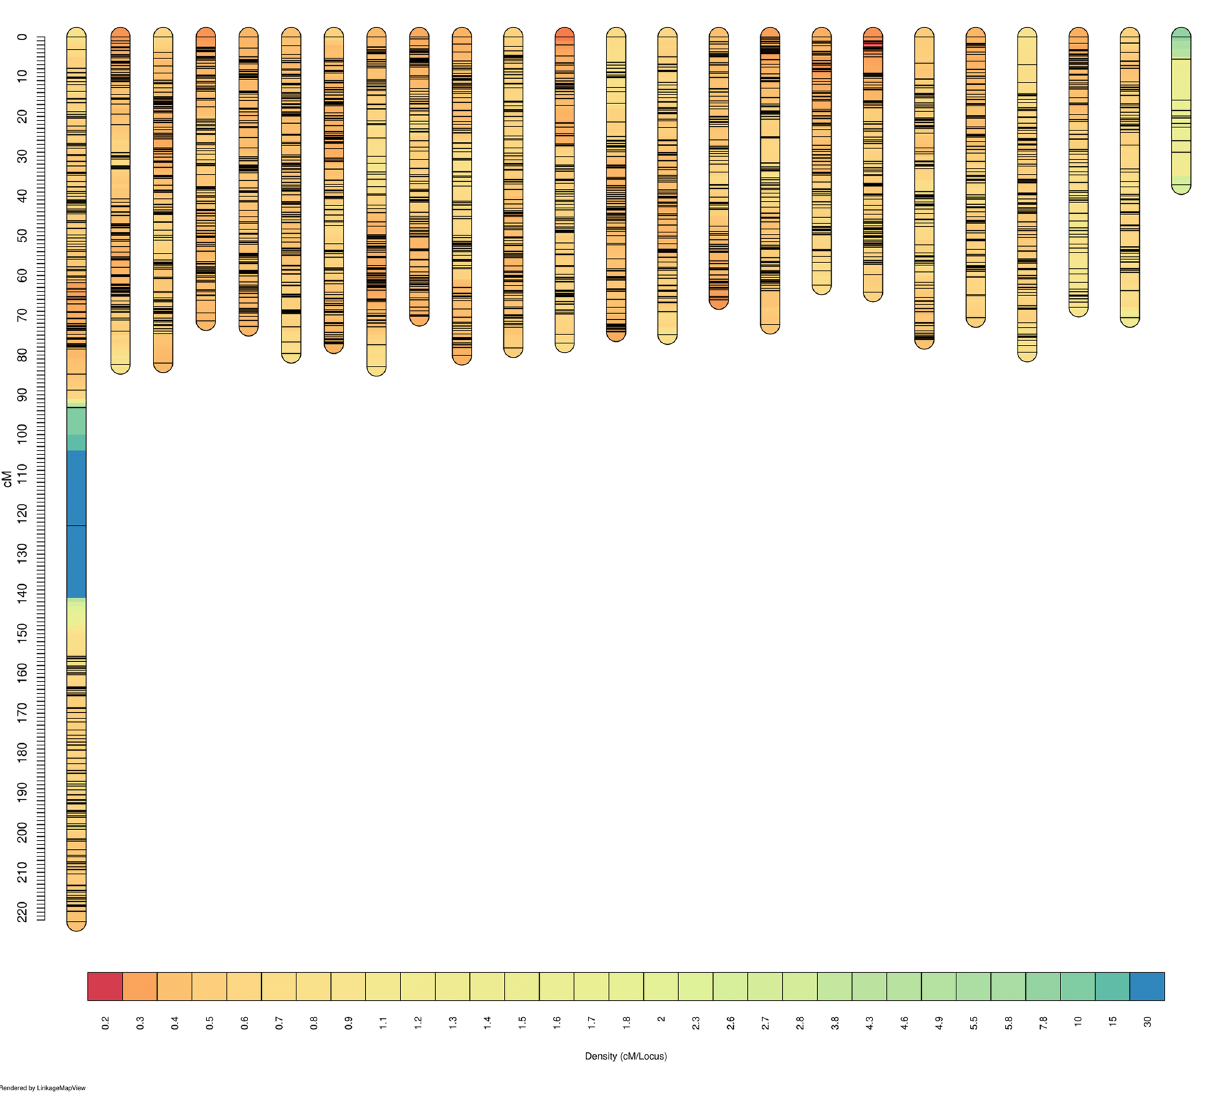
Figure 1. Genetic map originating from a subset of 70% shared RAD loci among individuals. The colouring of the marker intervals corresponds to a decrease in density, from red to by European seabass and gilthead seabream, with medaka, tilapia, and stickleback showing the fewest homolo- gies. Homologies in the coding regions with one hit, between meagre and the six species, resulted the high- est against stickleback followed closely by yellow croaker. The percentage of each meagre LG, that was found homologous to a chromosome, shows the degree of synteny between meagre and each of the 6 species. The average percentage of homologous markers of the 24 meagre LGs are 76.4%, 80,4%, 90.4%, 90.6%, 86.1%, 92.4% for stickleback, tilapia, medaka, gilthead seabream, yellow croaker and European seabass, respectively (Fig. S1). European seabass showed the highest percentage of homologies along the meagre LGs with 92.4%. Medaka (90.4%), showed a disproportionately high percentage in relation to the count of homologies shown, being the second highest along with gilthead sea bream. The corresponding order of the meagre LGs and the homologous chromosomes of the 6 species is shown in Table S3. We built six Circos plots to visualize these homologies, each for every comparison. Firstly, Fig. S2 shows the syntenic relationships between yellow croaker and meagre, where it is observed that three meagre LGs (1, 10, 17) showed 1:2 homology with 3 pairs of yellow croaker chromosomes, 1–21, 5–24, 4–9 respectively, while the rest chromosomes showed 1:1 homology. Secondly, Fig. S3 reveals the homologies between stickleback and meagre. Six meagre LGs showed 2:1 homology with three stickleback chromosomes, while the remaining meagre LGs showed 1:1 homology with the rest stickle- back chromosomes. Thirdly, Fig. S4 shows the homologies between meagre and European seabass. Meagre LG1 was found 1:2 homologous to seabass chromosomal pair 2–6, while the remaining chromosomes were found 1:1 homologous. Fourthly, Fig. S5 illustrates the high degree of homology between meagre and medaka, where meagre LG1 was found 1:2 homologous, to medaka chromosomal pair 6 -10, and the 22 remaining chromosomes